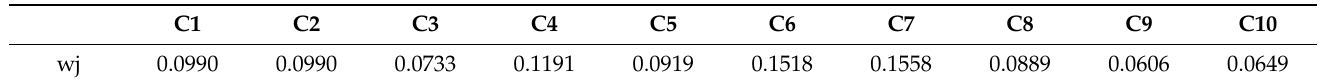
Table 6. Weight coefficients of